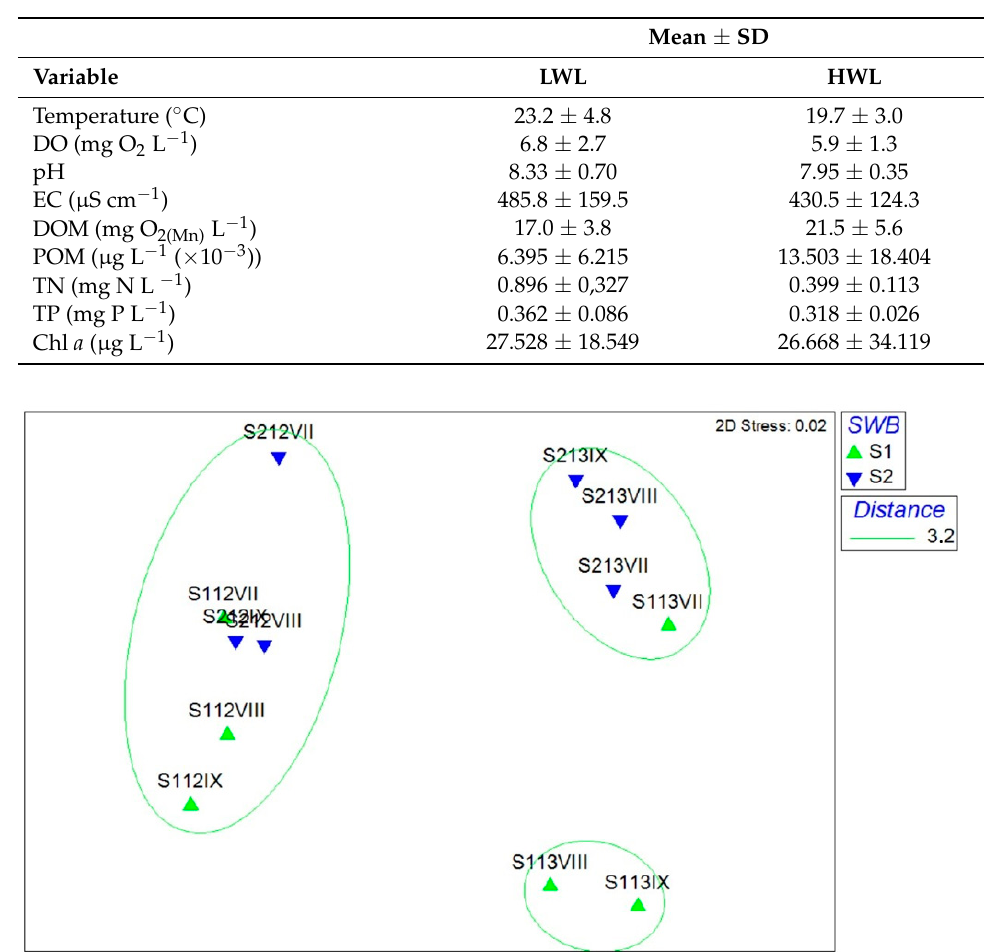
Figure 2. Non-metric multidimensional scaling (NMDS) ordination based on differences in summer environmental conditions in 2012 (LWL) and in 2013 (HWL). Explanation of symbol codes plotted in the diagram: e.g., S112IX refers to S1—shallow water body, 12—year 2012, roman numerals indicate the months.